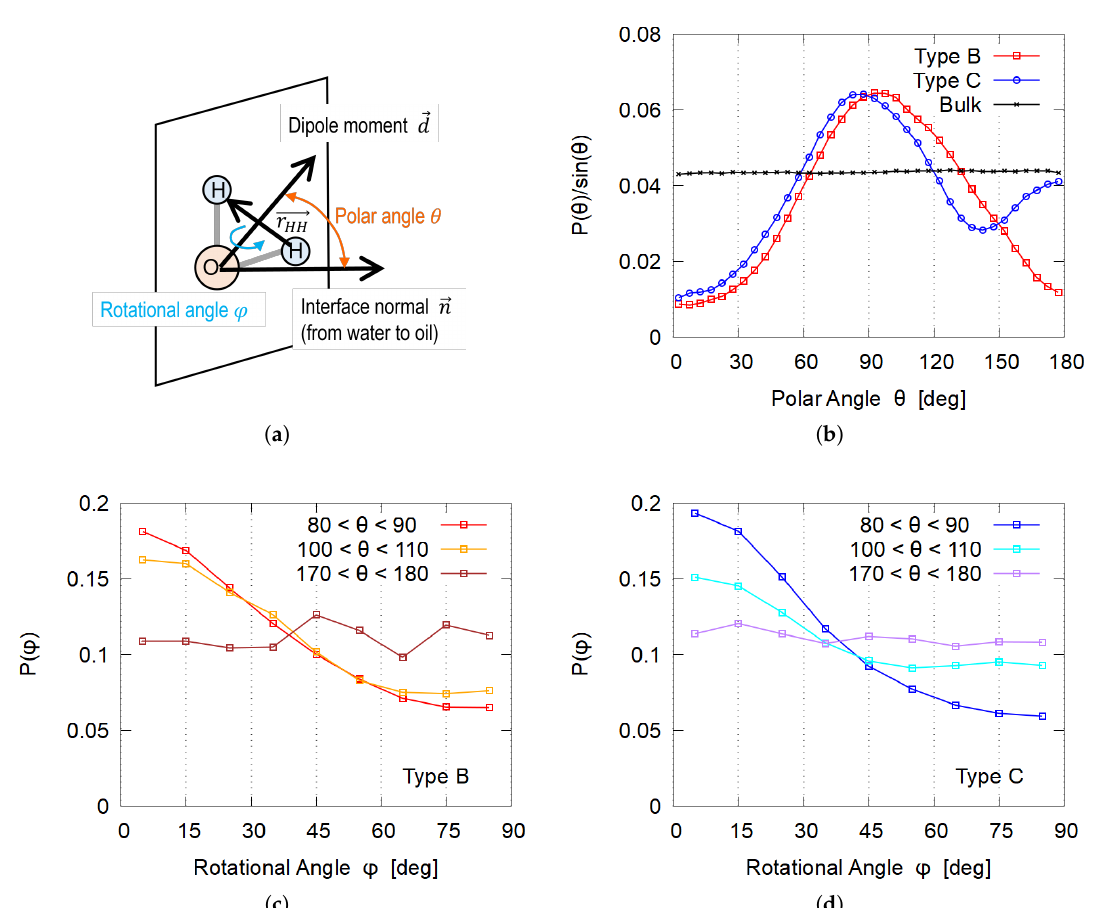
Figure 7. Orientational distribution of water molecules in thin water layer between the adsorbed cellulose nanocrystal and the oil phase. “Bulk” in ( b ) indicates the orientation distribution of water molecules far from both the cellulose and the water–oil interface. ( a ) Definition of orientational angles, θ and ϕ . ( b ) Distribution of θ . ( c ) Distribution of ϕ for Type B. ( d ) Distribution of ϕ for Type